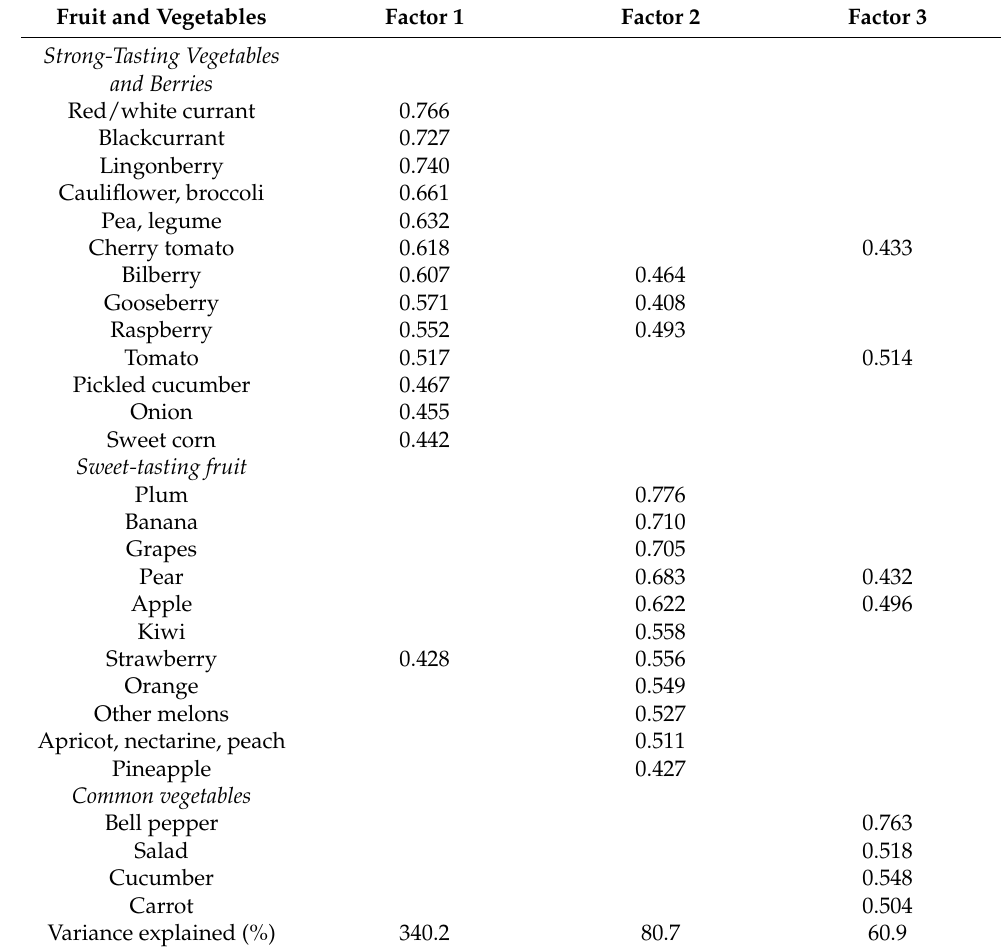
Table 3. The results of the factor analysis, rotated variable loadings of the extracted preference components for children ( n = 128) (correlation coefficients). For simplicity, only coefficients above 0.400 are shown. The labels of new variables are in